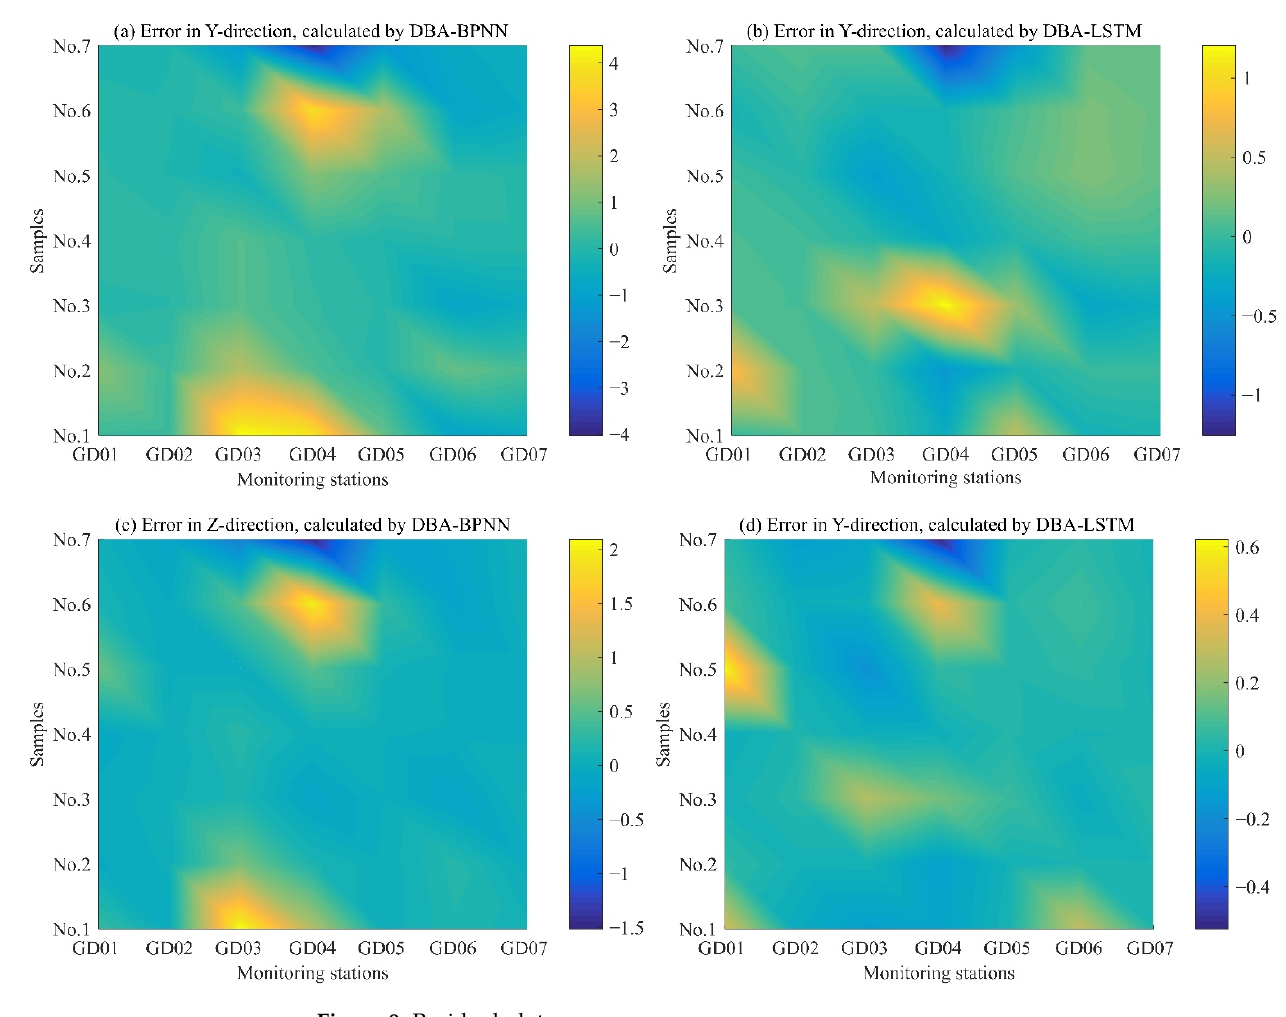
Figure 9. Residual plots.